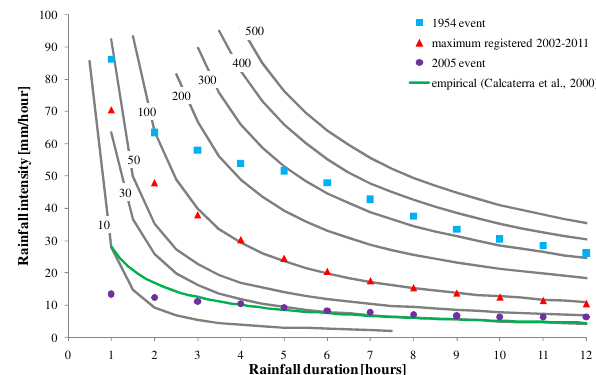
Fig. 10. Comparison between registered rainfalls and simulated ID Figure 10. Comparison between registered rainfalls and simulated ID curves at fixed values of 2 total instable volumes (thousands of m 3 ) 3